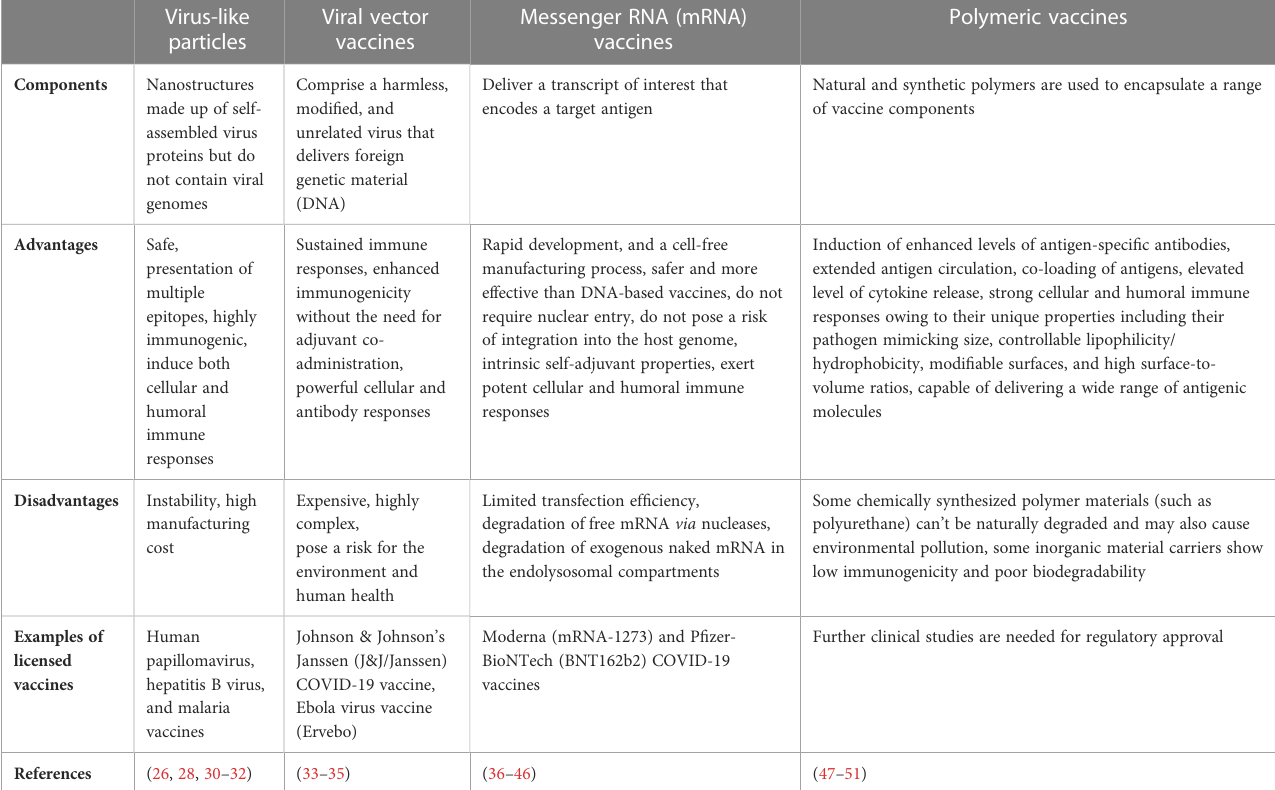
TABLE 1 Antigen delivery platforms and their immunological